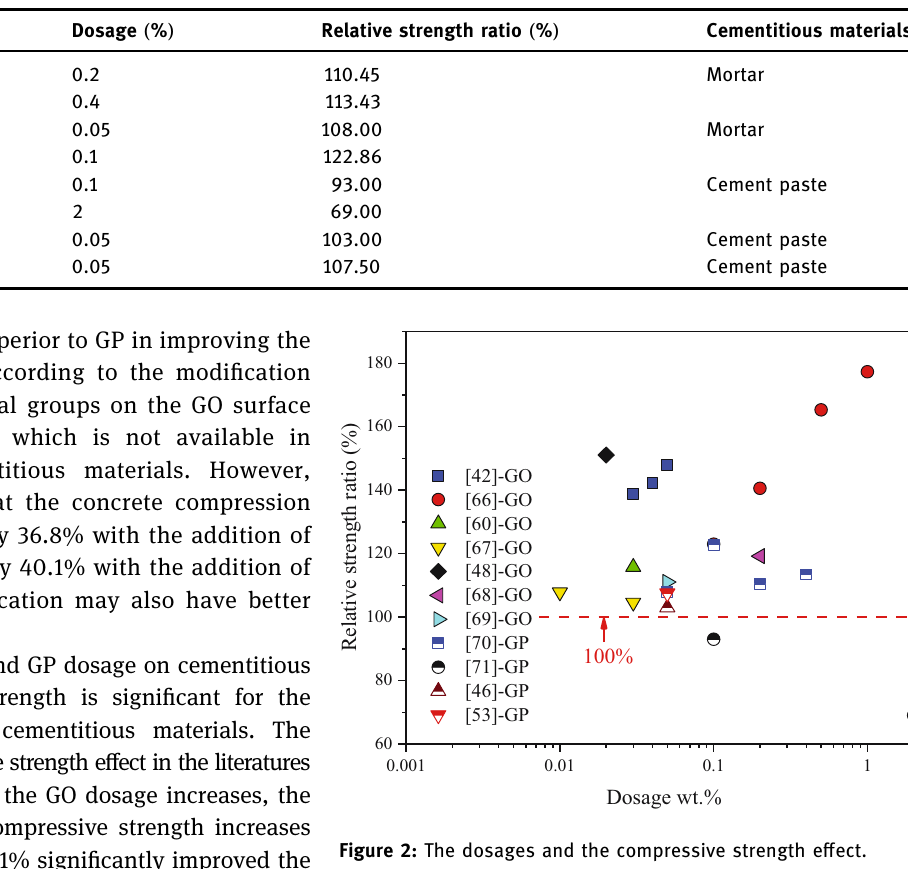
Table 2: Compressive strength of GP - modi fi ed cementitious materials